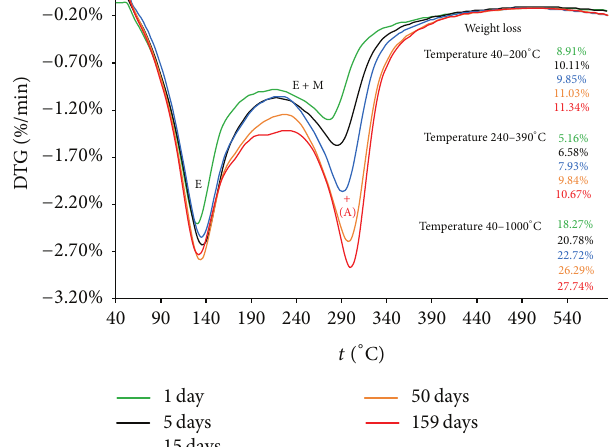
Figure 5: DTA analysis of hydrated ye’elimite clinker exposed to environment of saturated water vapour (E is ettringite, M is calcium monosulfoaluminate hydrate, and A is calcium aluminate hydrate